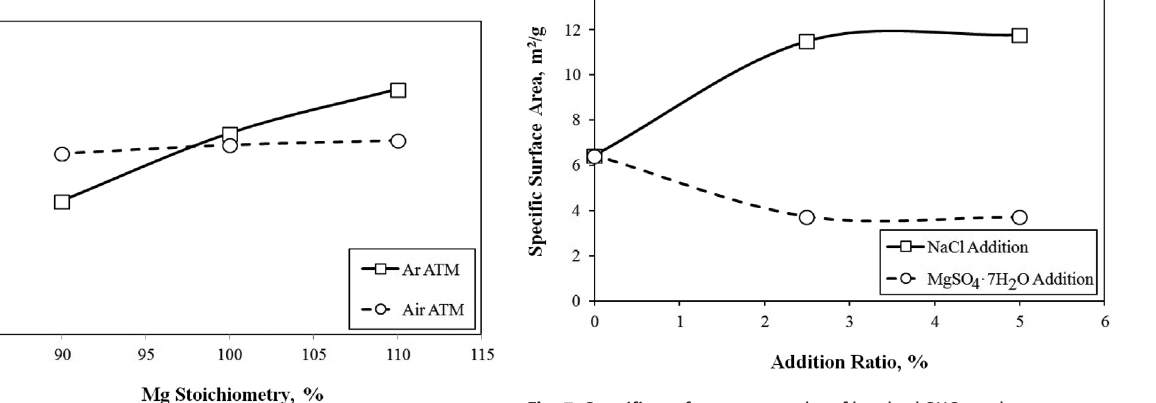
Fig. 7: Specific surface area results of leached SHS products synthesized under argon atmosphere and stoichiometrically 100% Mg addition with increasing NaCl and MgSO 4 ·7H 2 O addition